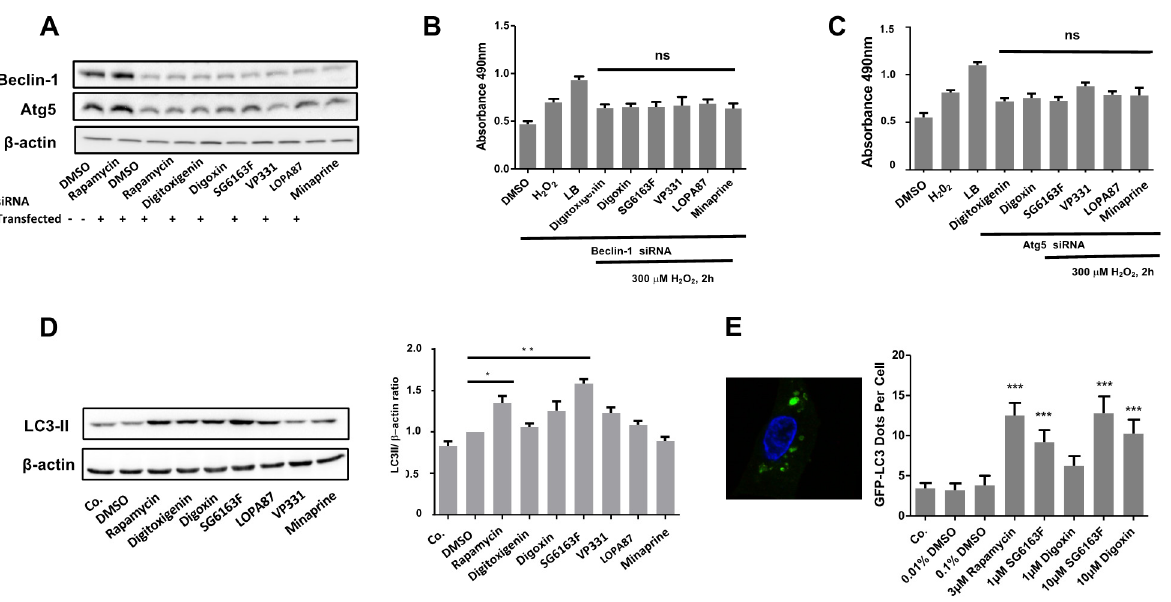
Figure 4. RNVCs cell death inhibition by compounds requires ATG5 and BECLIN-1. ( A ) RNVCs were transfected with pools of siRNAs targeting ATG5 or BECLIN-1, cultured for 48 h, and expression levels of both proteins were evaluated by Western blot. ( B , C ) Following BECLIN-1 ( B ) and ATG5 ( C ) siRNA transfection, LDH release was measured in RNVCs treated with 300 µ M H 2 O 2 for 2 h. Data are presented as mean ± SEM with one-way ANOVA, Sidak’s multiple comparisons test. ns.—not significant vs. H 2 O 2 treated and siRNA transfected cells. ( D ) Protein level of LC3-II in RNVCs following treatment by compounds for 6 h was analyzed by Western blot, and the LC3II/b-actin ratio was determined in comparison to DMSO. Data are presented as mean ± SEM with one-way ANOVA, Sidak’s multiple comparisons test. *, p < 0.05, **, p < 0.01 vs. DMSO. ( E ) Redistribution of GFP-LC3. 24 h after transient transfection with a GFP-LC3 coding plasmid, cells were treated for 6 h with DMSO, rapamycin, and 1 and 10 µM of SG6163F and Digoxin. A representative cell is shown (left). The frequency of dots per cell (right) was quantified for 150 cells for each condition. Dots correspond to clear vacuolar distribution of GFP-LC3. Nuclei were stained by 0.5 µM Hoechst 33342. Data are presented as mean ± SEM with one-way ANOVA, Sidak’s multiple comparisons test. ***, p < 0.001 vs. DMSO. ns, not significant. +, transfection; -, no transfection.